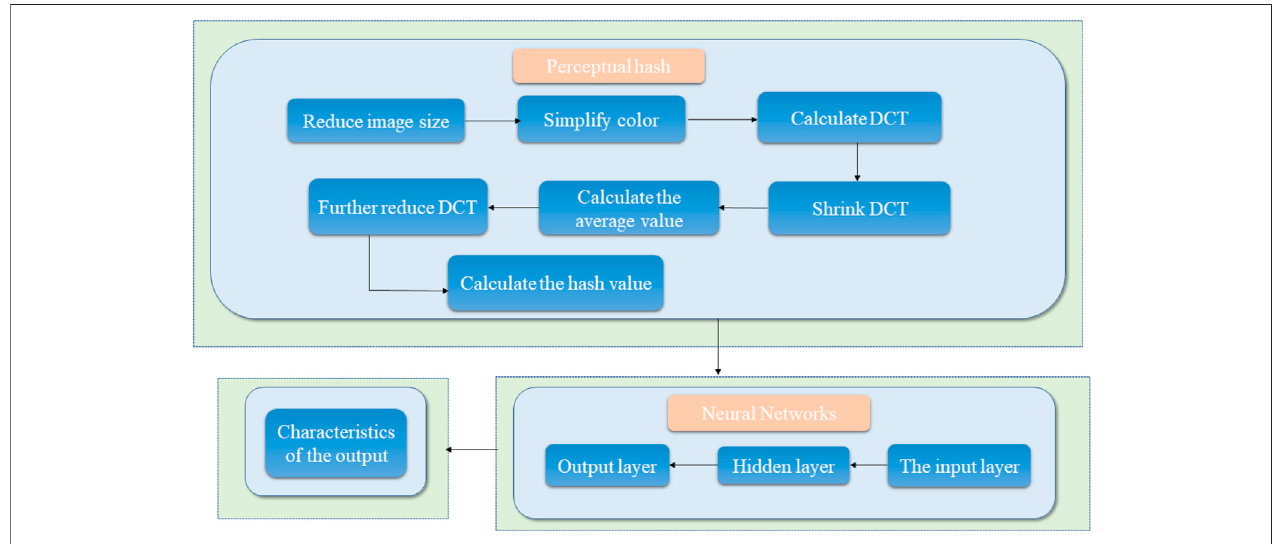
FIGURE 3 | Schematic diagram of the robustness feature acquisition of medical images based on perceptual hashing and a neural network.